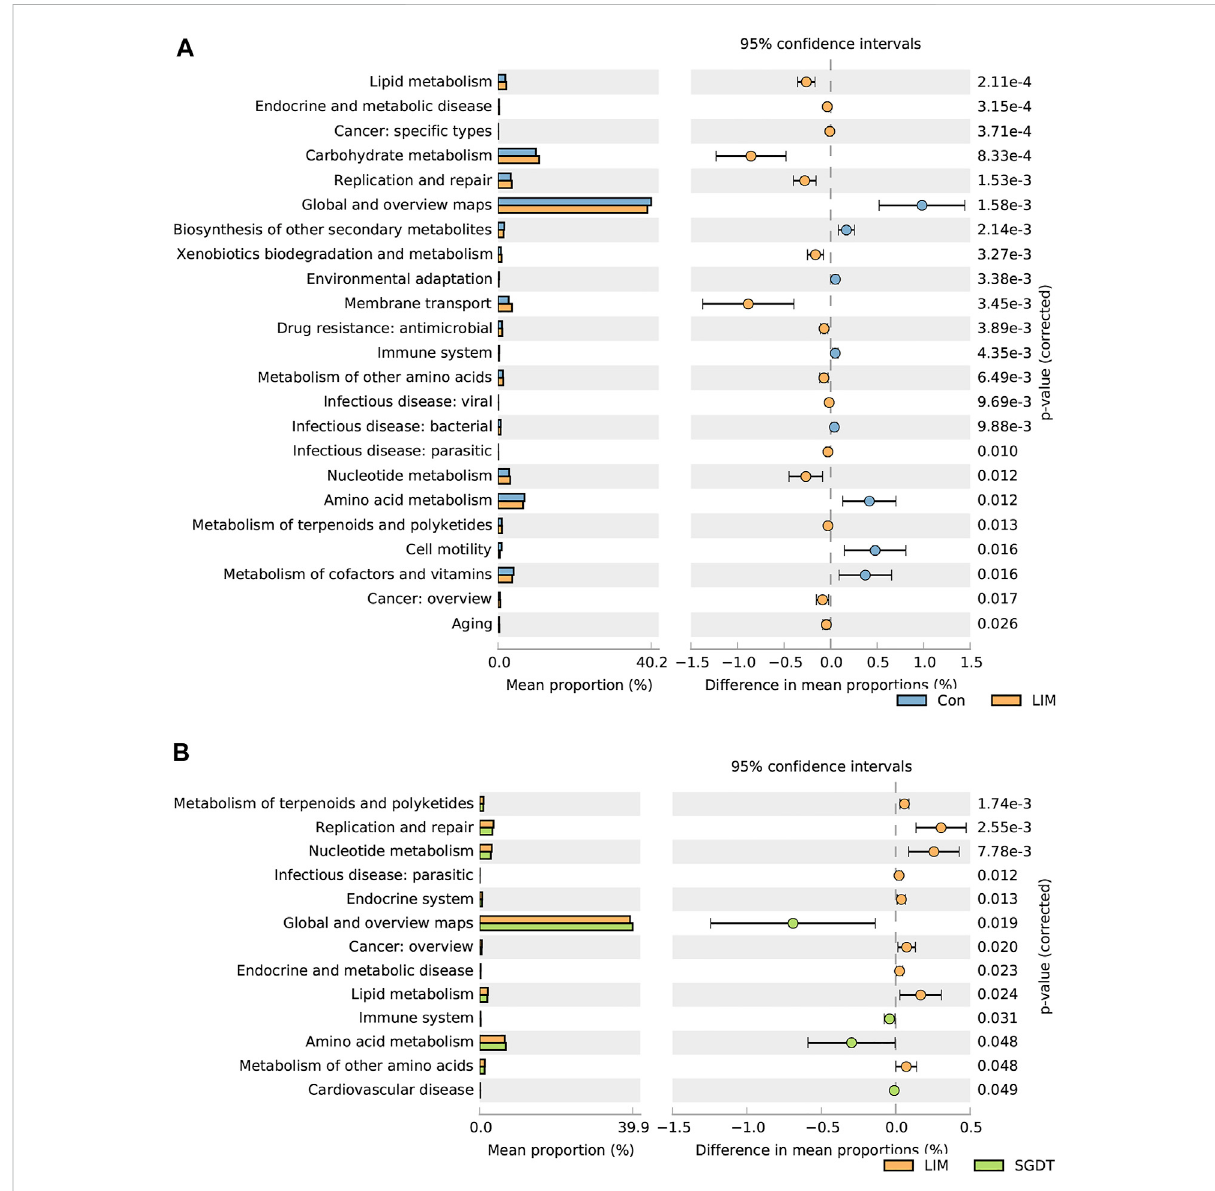
FIGURE 2 Comparison of gut microbiota functional pathways between Con and LIM (A) , and between LIM and SGDT (B)